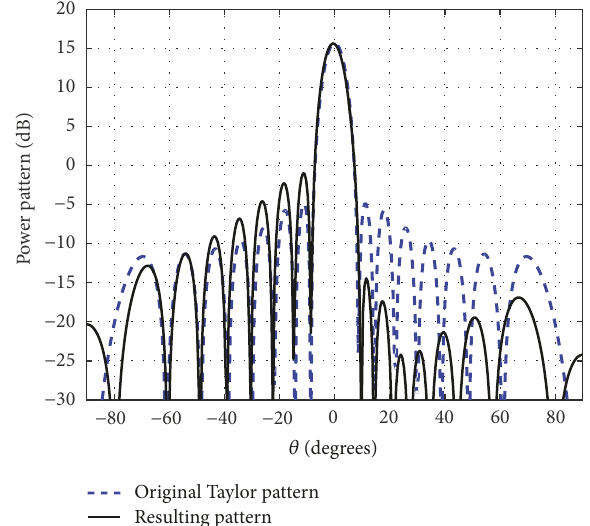
Figure 6: Radiation patterns of the original Taylor pattern and the proposed arrays for 𝑁 = 16 , 𝑑 = 𝜆/2 , and 𝑃 = 6.75 ∘ .